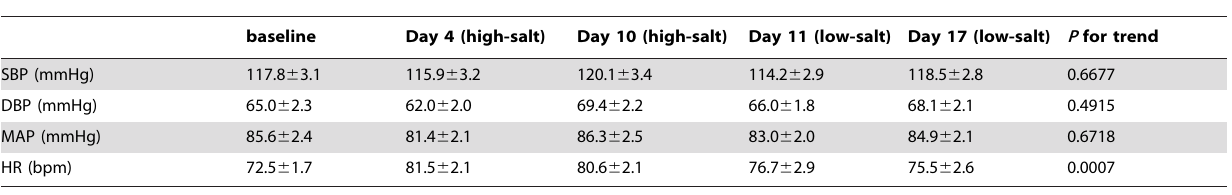
Table 4. Blood Pressure and Heart Rate Changes during Dietary Intervention (n=20).